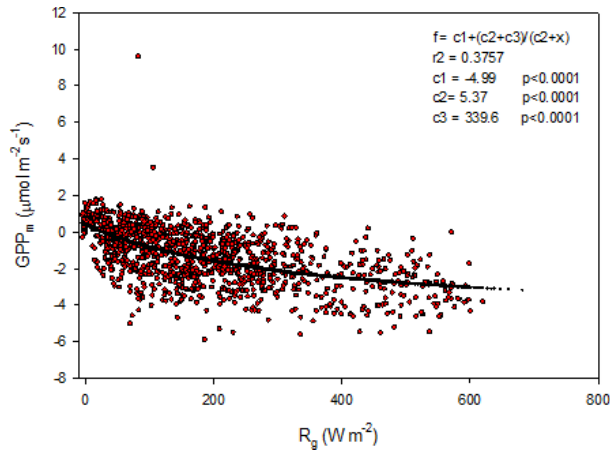
Table 1. Result of stepwise linear regression with CO 2 flux as a dependent variable. The normality test failed, but significance in all variables was confirmed with Wilcoxon signed-rank tests. T a is air temperature, θ is soil moisture and GI is the green index.